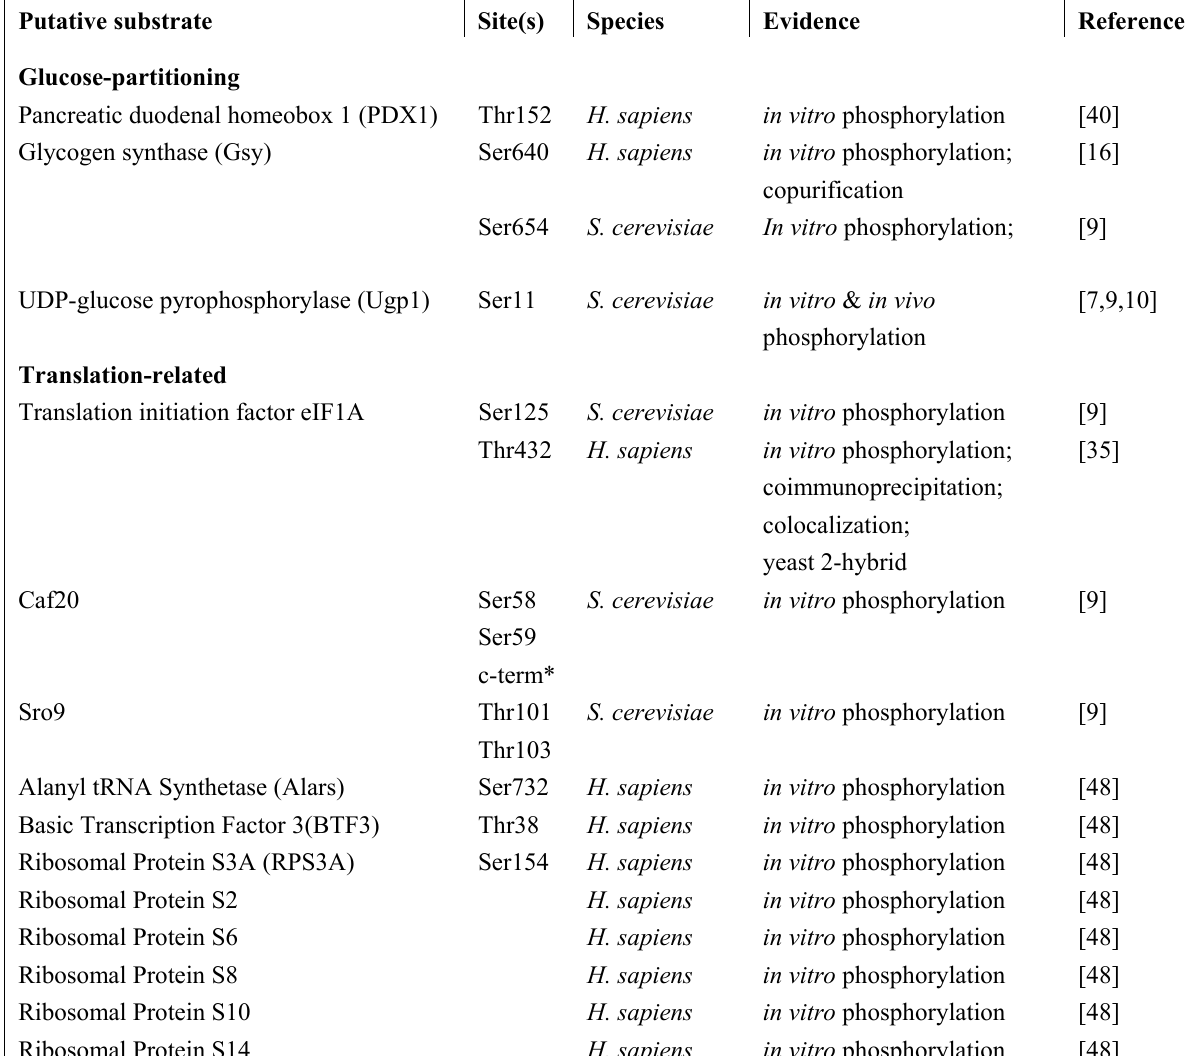
Table 1. In vitro and in vivo substrates of PAS